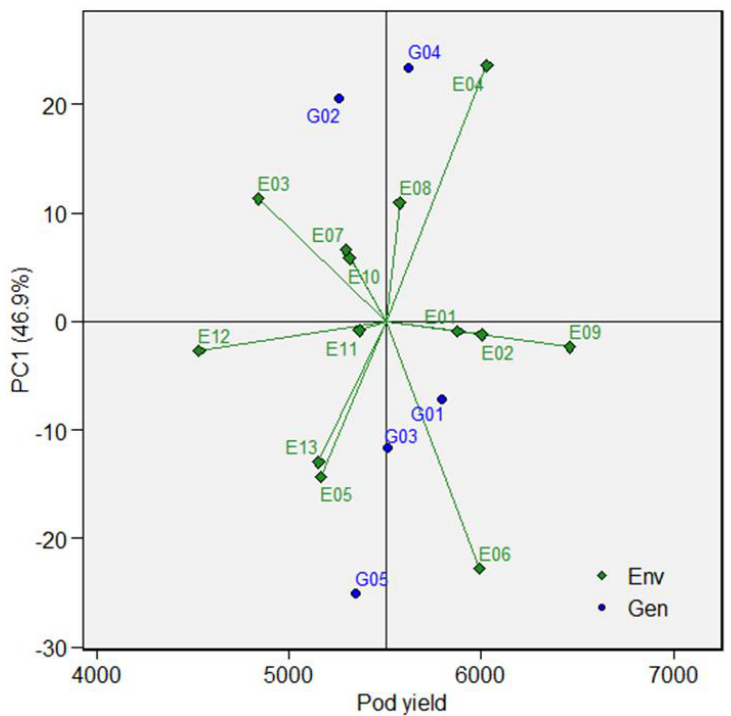
Figure 8. AMMI1 biplot (mean vs. PC1) for pod yield (kg/ha) with five peanut cultivars (G01 — Bailey, G02 — FloRun107, G03 — Sullivan, G04 — TUFRunner297, G05 — Wynne) in 13 environments (E01 — Cap17Rf, E02 — Cap17RfIR, E03 — Dwd16Rf, E04 — Dwd16RfIR, E05 — Rkm17Rf, E06 — Rkm17RfIR, E07 — Rkm18Rf, E08 — Rkm18RfIR, E09 — Suf17Rf, E10 — Suf18Rf, E11 — Suf18RfIR, E12 — Suf20Rf).